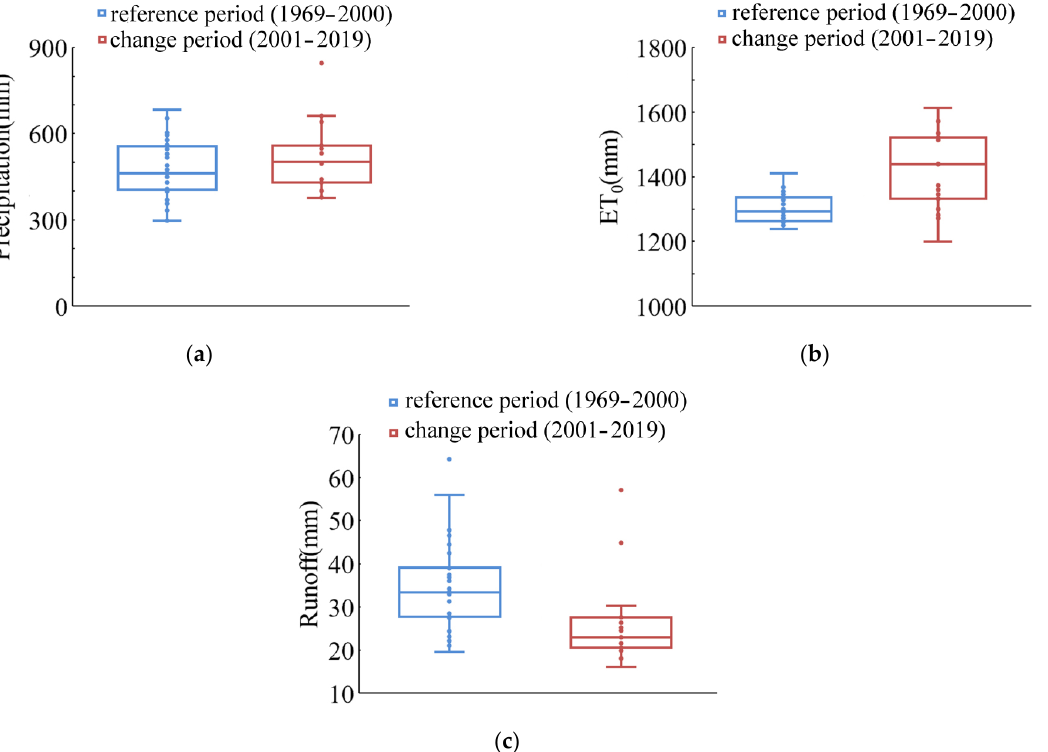
Figure 4. Characteristics of hydrological and meteorological elements during reference period and change period: ( a ) precipitation; ( b ) ET 0 ; ( c ) runoff. Table 1. The variation coefficient of hydrological and meteorological elements in the past 50 years. Period